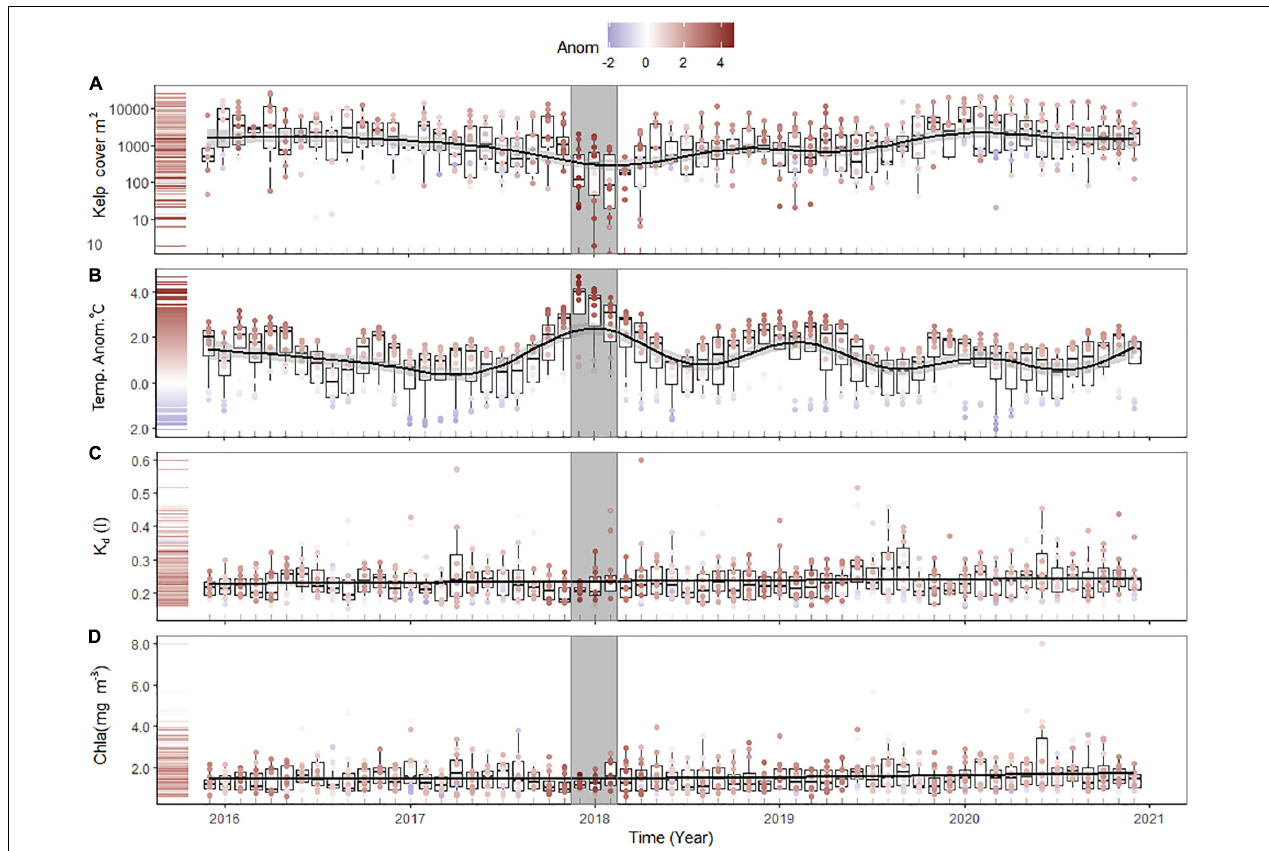
FIGURE 4 | Combined time series of (A) kelp coverage (y-axis log transformed), (B) temperature anomalies, water clarity- K d (C) , and chl -a concentration (D) . Color scale of points represents the temperature anomaly for each monthly observation for each location. Trends are fitted by GAM including standard error. Gray box indicates the 2017–18 marine heat wave.